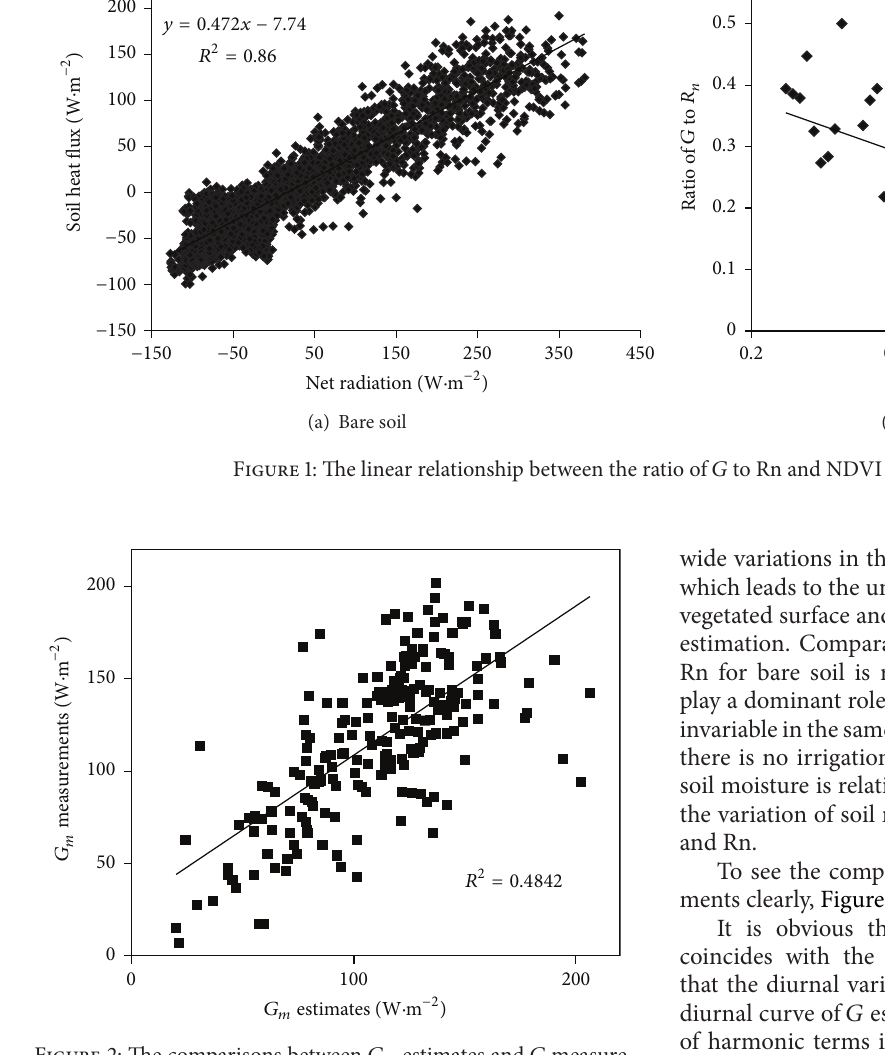
Figure 2: The comparisons between 𝐺 𝑚 estimates and 𝐺 measure- ments at YC Station in 2004.